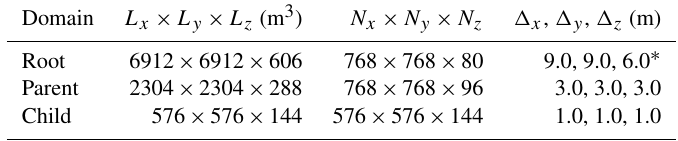
Table 2. Dimensions ( L ), number of grid points ( N ) and grid resolutions ( (cid:49) ) of the model domains in the x , y and z directions. Domain